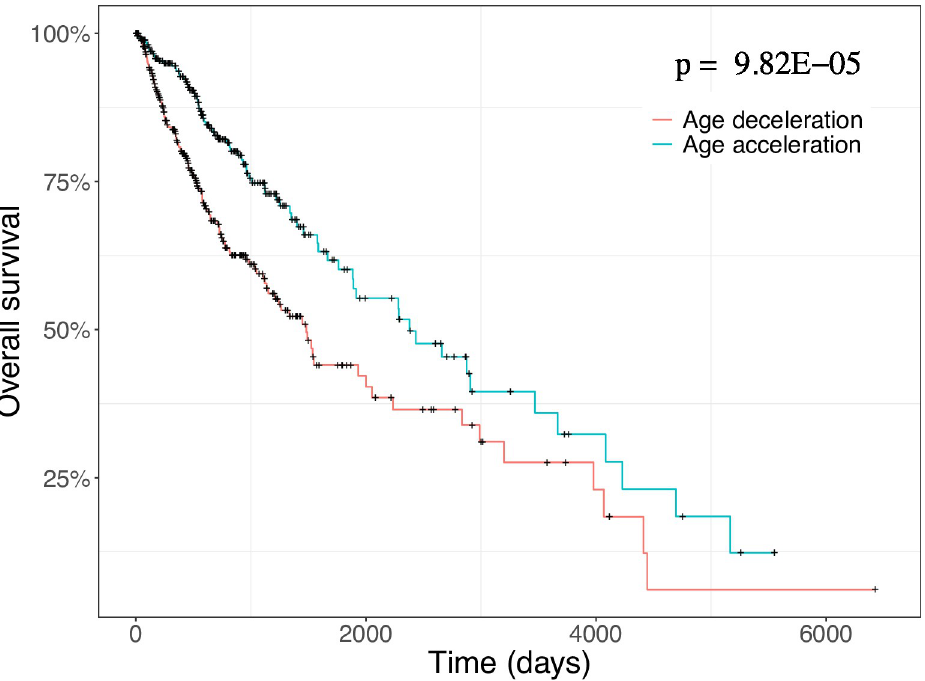
Fig 1. Kaplan-Meier curves for patient overall survival between epigenetic age acceleration and epigenetic age